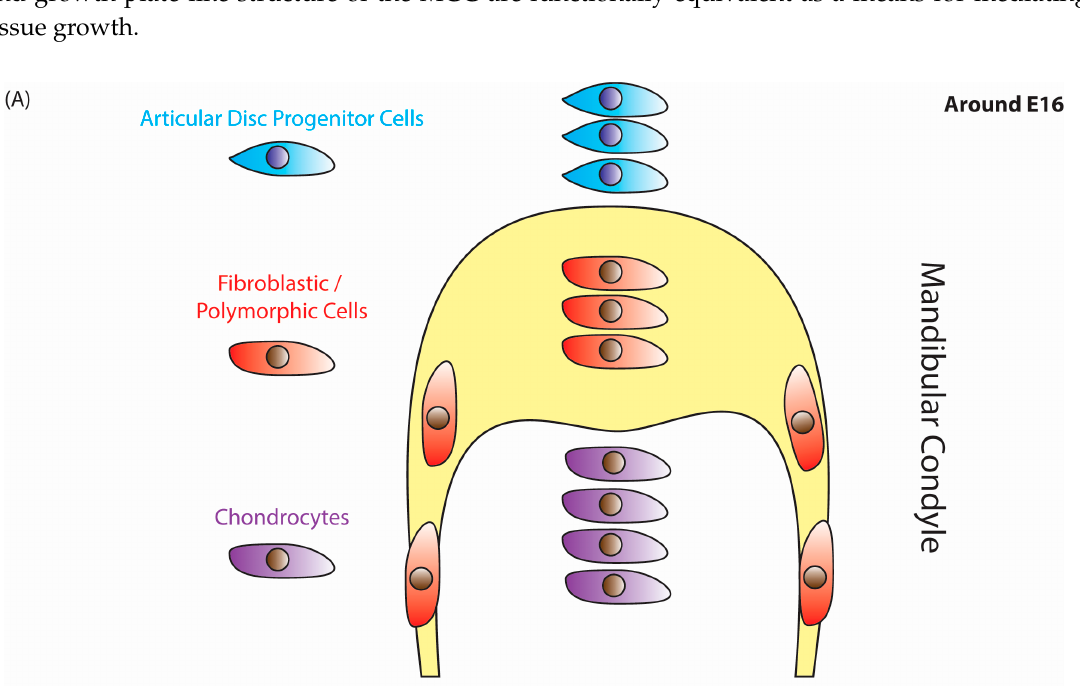
Figure 2. Cell profile during mandibular condyle and articular disc development. ( A ) Schematic of cells types within a developing mandibular condyle and the mesenchymal precursors of the articular disc around E15. The articular disc proper has not yet formed. The anterior end of the mandibular condyle harbours a layer of fibroblastic and polymorphic cell types that overlay an inner mass of chondrocytes. Above them lies a group of mesenchymal articular disc precursor cells; ( B ) Around E18